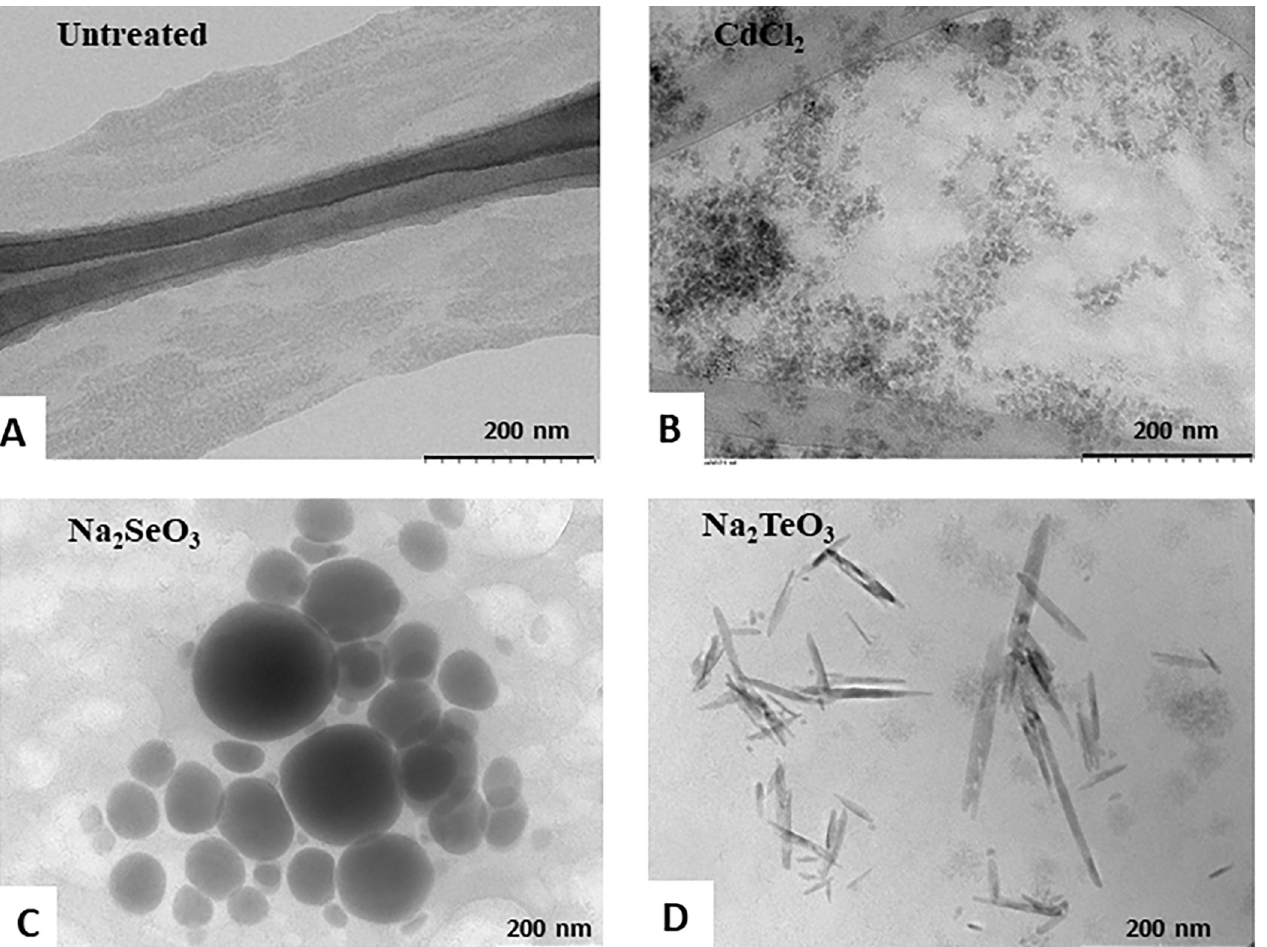
Fig 4. TEM NS of CdS QDs, Se, or Te by MF05 cells. Synthesis of NS by MF05 whole-cell in anaerobiosis (A) control and after treatments with (B) CdCl 2 ; (C) Na 2 SeO 3 or (D) Na 2 TeO 3